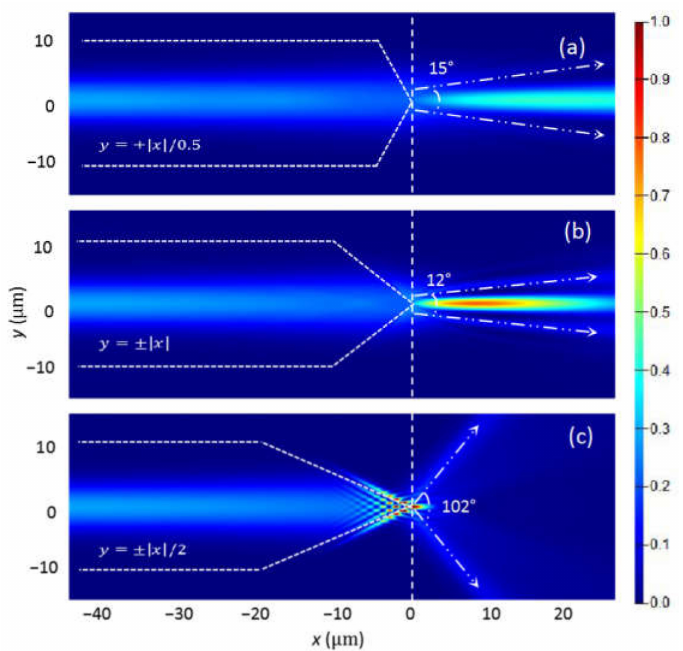
Figure 2. The light intensity distribution in the model for the axicon lensed fiber with the tapered